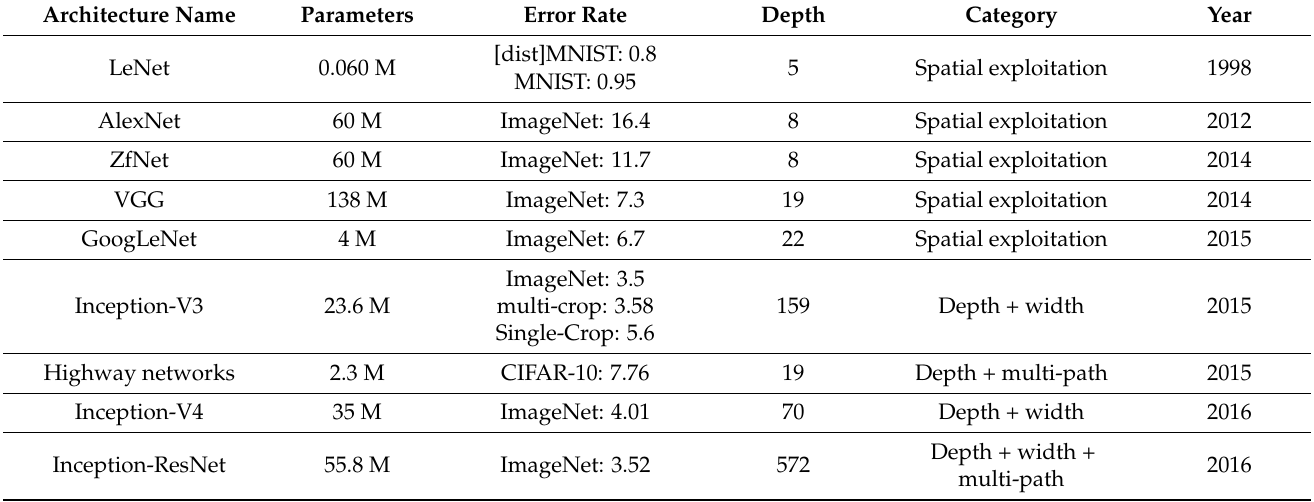
Table 7. Performance comparison of different deep architectures